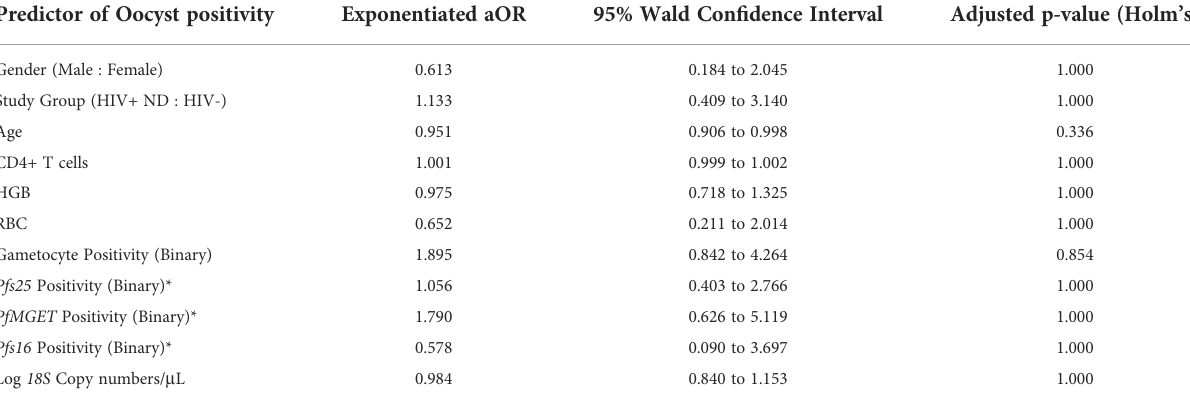
TABLE 3 GEE Transmission Omnibus